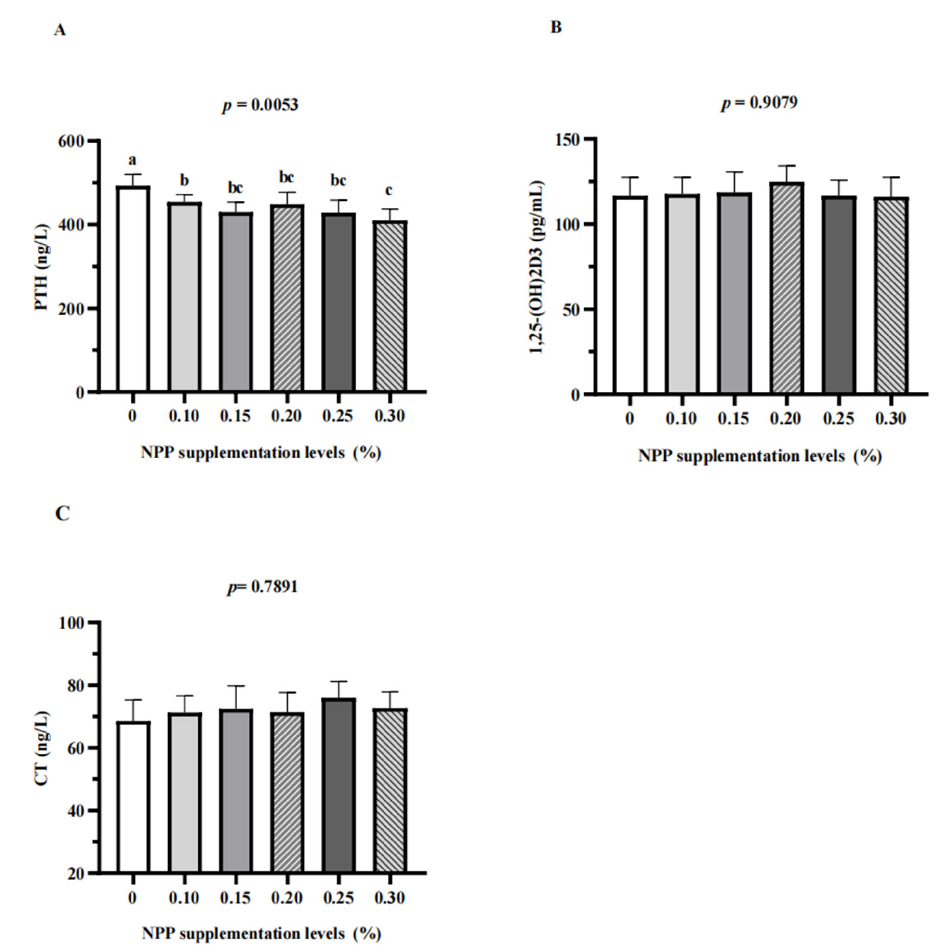
Figure 2. Effect of the level of dietary NPP supplementation on the serum calcium and phosphorus metabolism-related hormones of Hy-Line Brown laying hens (69–78 weeks of age) fed a phytase- containing diet. PTH = parathyroid hormone ( A ); 1,25-(OH)2D3 = 1,25-dihydroxy-vitamin D3 ( B ); CT = calcitonin ( C ). a–c Mean values within one row lacking a common superscript differ ( p < 0.01). The statistical unit was each hen ( n = 10; at the end of feeding, two hens per replicate were selected randomly for sample collection).